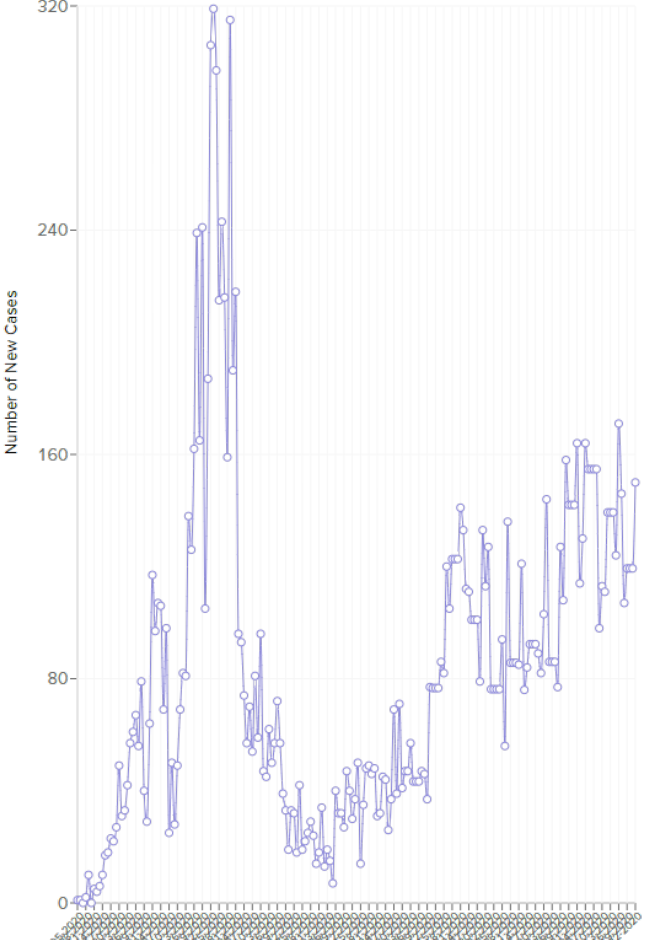
Figure 1: Confirmed Cases of COVID-19 in the Selected